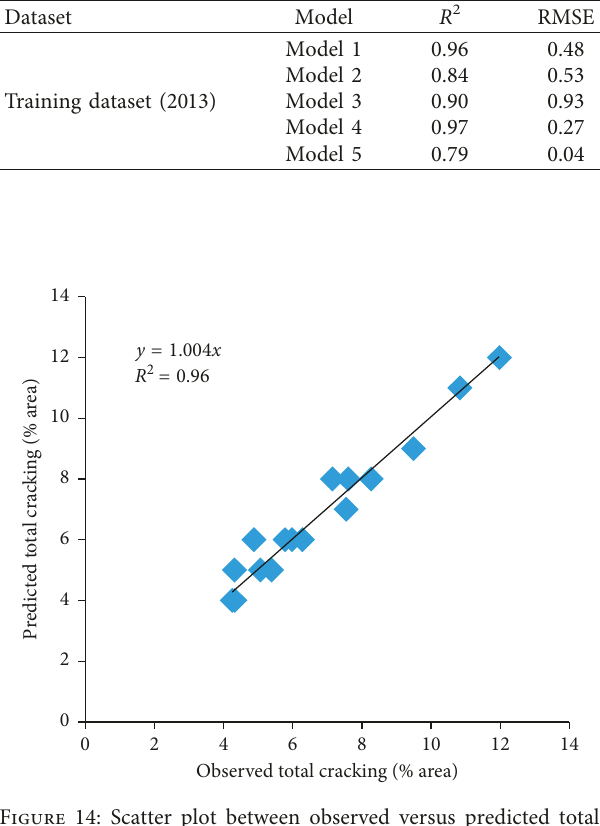
Figure 14: Scatter plot between observed versus predicted total cracking for training.